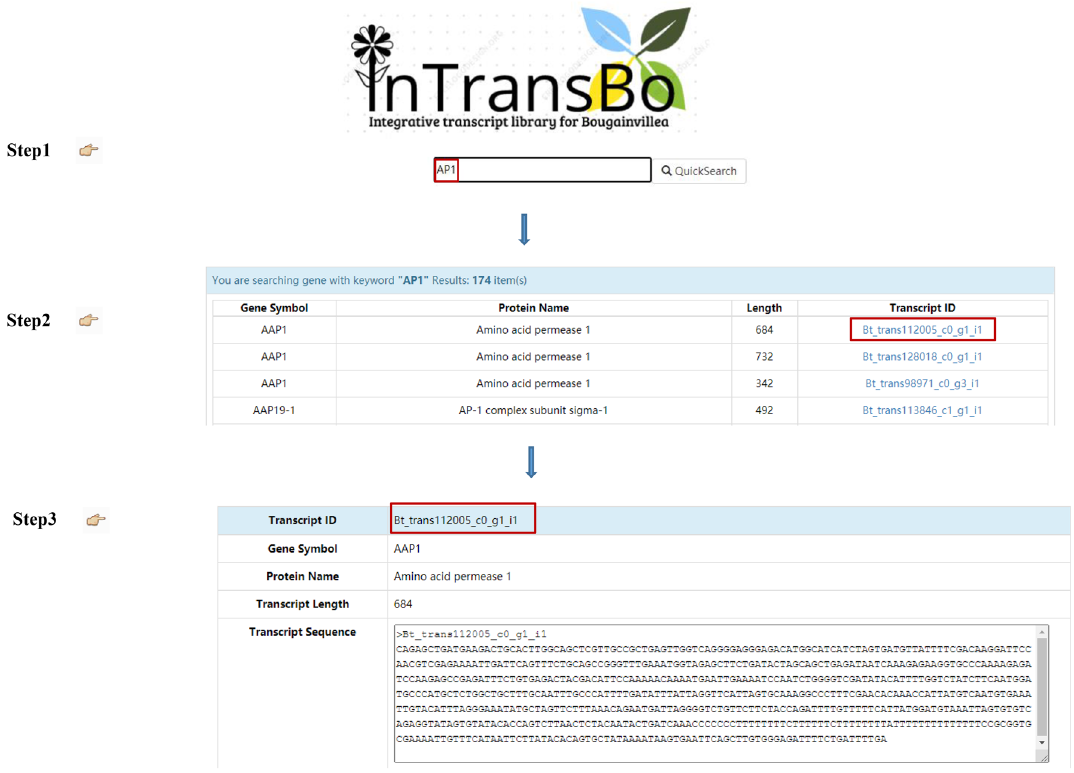
Figure 3. Data retrieval by keyword search